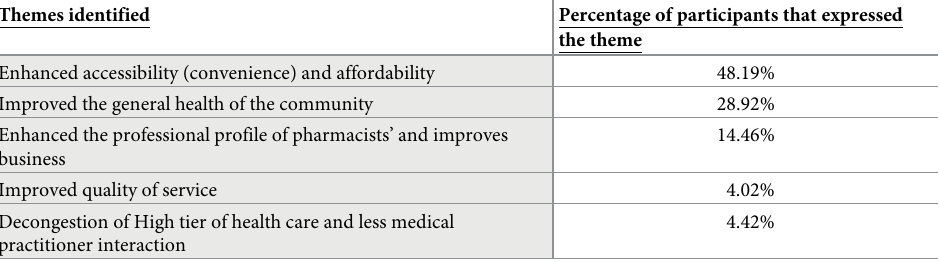
Table 2. Thematic analysis for participants that expressed the benefit of the provision of these services within a community pharmacy (number of responses = 249). Themes